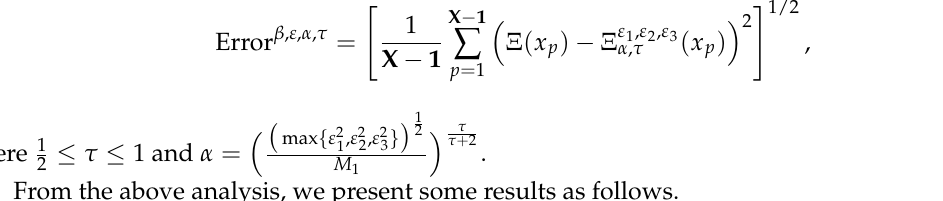
( b ) The error estimation between Ξ and Ξ ε 1 , ε 2 , ε 3